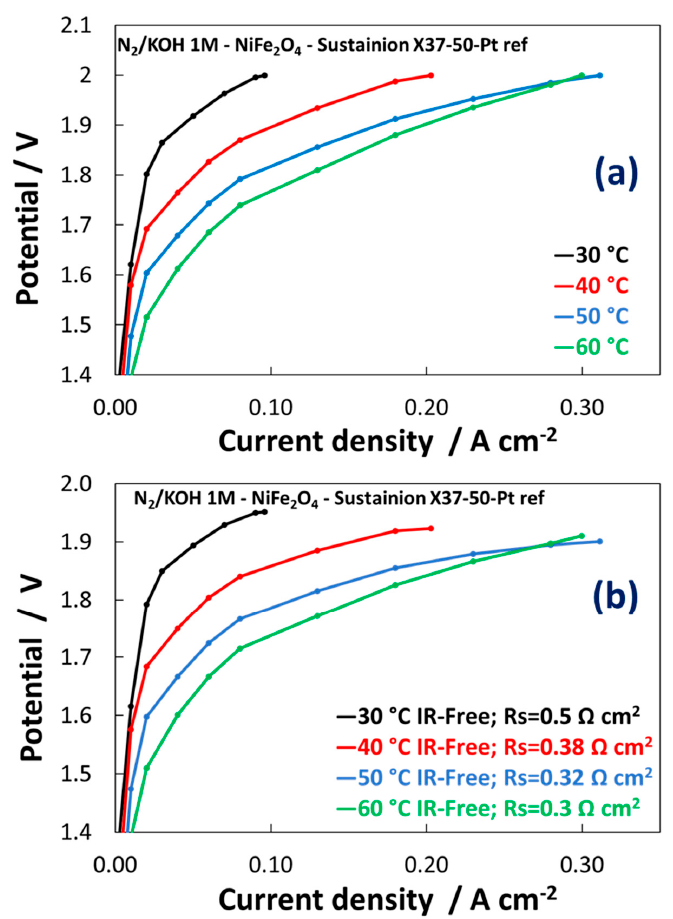
Figure 8. Polarization curves carried out at 1 M KOH for MEAs including the NiFe 2 O x -based electrocatalysts at the anode. ( a ) Polarisation curves; ( b ) IR-free polarization